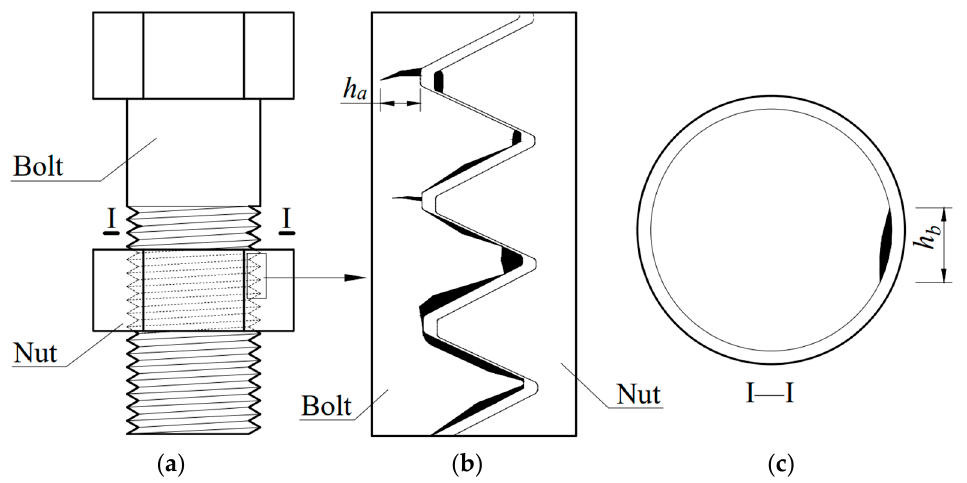
Figure 1. Schematic Diagram of Thread Damage: ( a ) Bolt and nut; ( b ) Thread tooth damage ampli- fi cation diagram; ( c ) Ⅰ - Ⅰ cross-section.